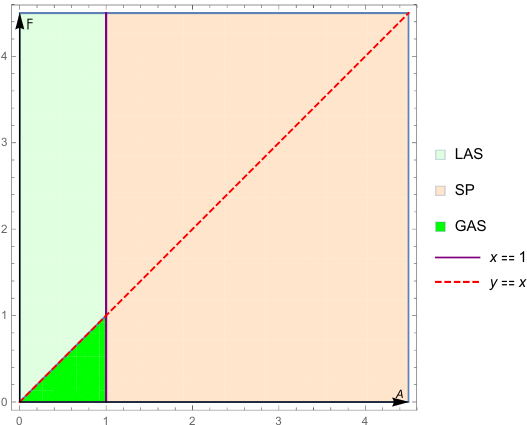
Figure 3. The area of the global asymptotic stability